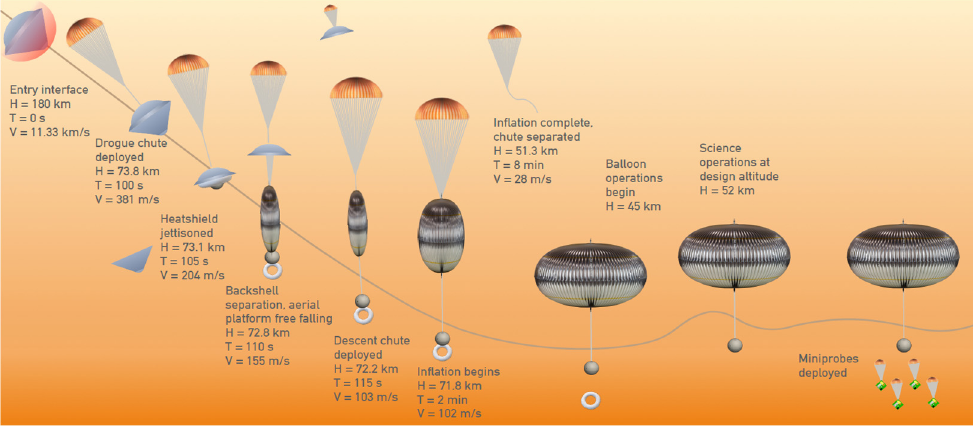
Figure 2. Balloon mission entry, descent, and deployment concept of operations. The 52 km fixed- altitude balloon mission is planned to be operational for one week and communicate both through an orbiter as well as direct communication to Earth. Mini probes will be deployed to sample the atmosphere below 52 km.